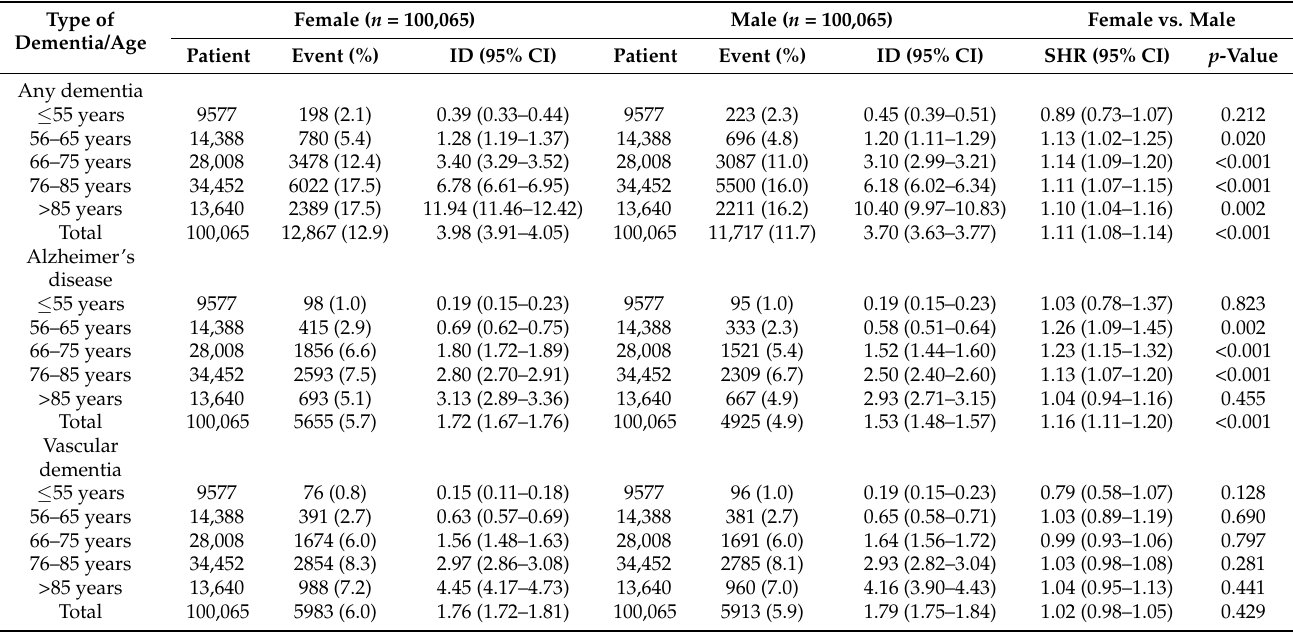
Table 3. The risk of dementia between sexes after propensity score matching.